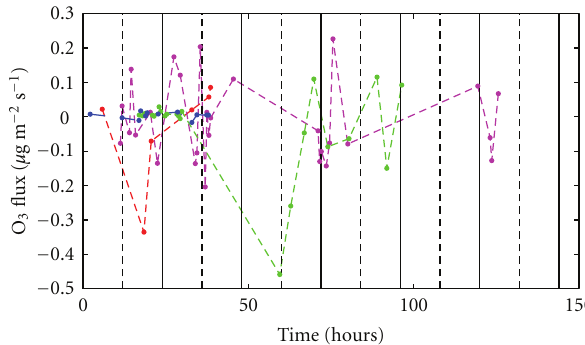
Figure 1: Time series of 30 min averaged O 3 fluxes (dots) during August–October 2009 showing the four main measurement peri- ods; red: 28-29 August (Yearday 240-241), magenta: 4–9 September (Yearday 247–252), blue: 3-4 October (Yearday 276–278), and green: 22–26 October (Yearday 295-299). Time in hours from 00:00 on the first day of each period is shown on the x -axis, with 12:00 and 00:00 marked sequentially with a dotted and solid vertical line,